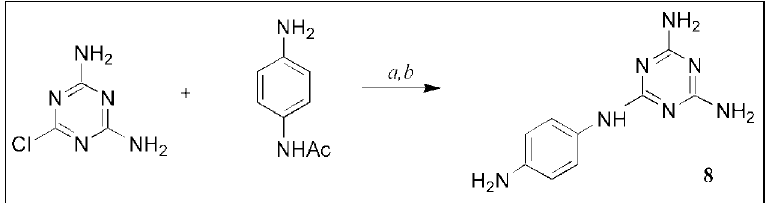
Figure 3 - Synthesis of compound 8. a , 1 eq NaOH; H 2 O (100 o C, 3 h). b , 1.2 M HCl (100 o C, 2